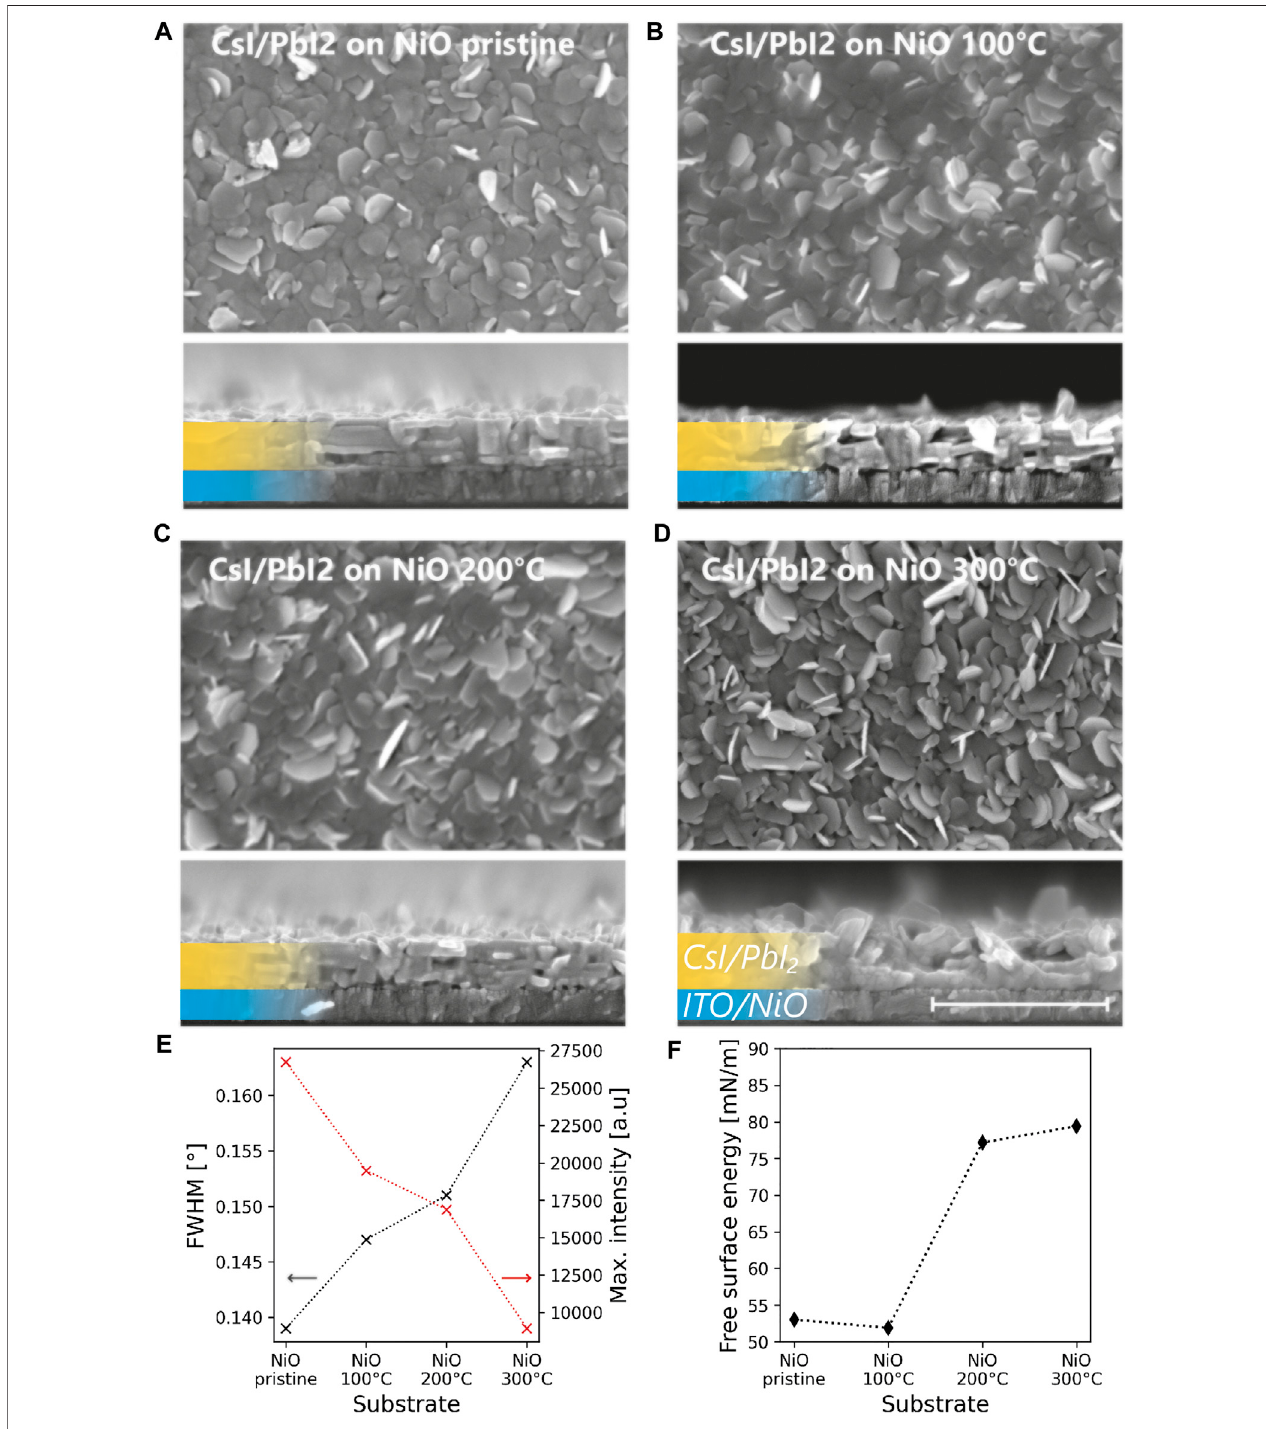
FIGURE1| EffectofannealingofNiOHTLontheCsI/PbI 2 precursor.SEMtopviewandcrosssectionofCsI/PbI 2 precursoron (A) pristineNiOandNiOannealedat (B) 100 ° C, (C) 200 ° Cand (D) 300 ° C. Themorphologychangesfromlayeredand compacton pristine NiO todisordered and roughonNiO annealedat 300 ° C.The scale bar shows a length of 1 μ m and applies to all SEM images. (E) Full-width-at-half-maximum and maximum intensity of the (001) diffraction peak ofPbI 2 grown on pristine and annealed NiO (F) Surface free energy of the pristine and annealed NiO surfaces measured by contact angle measurements.